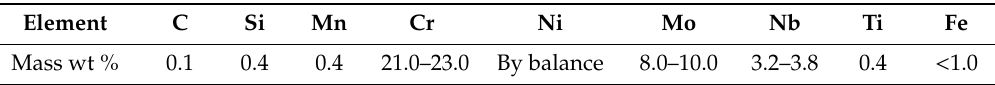
Table 1. Chemical composition of Inconel 625 (prior to the corrosion tests). Element